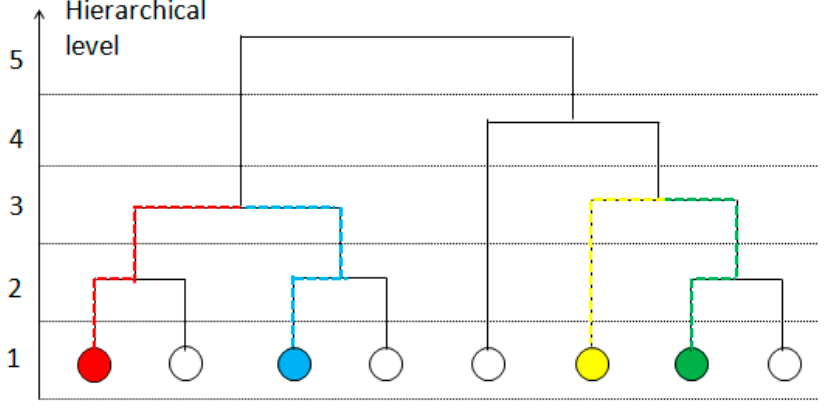
Figure 1. Example of a hierarchical tree.